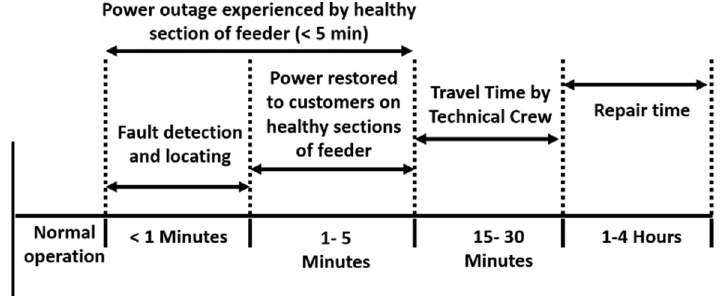
Figure 2. With smart fault detection and remote control.